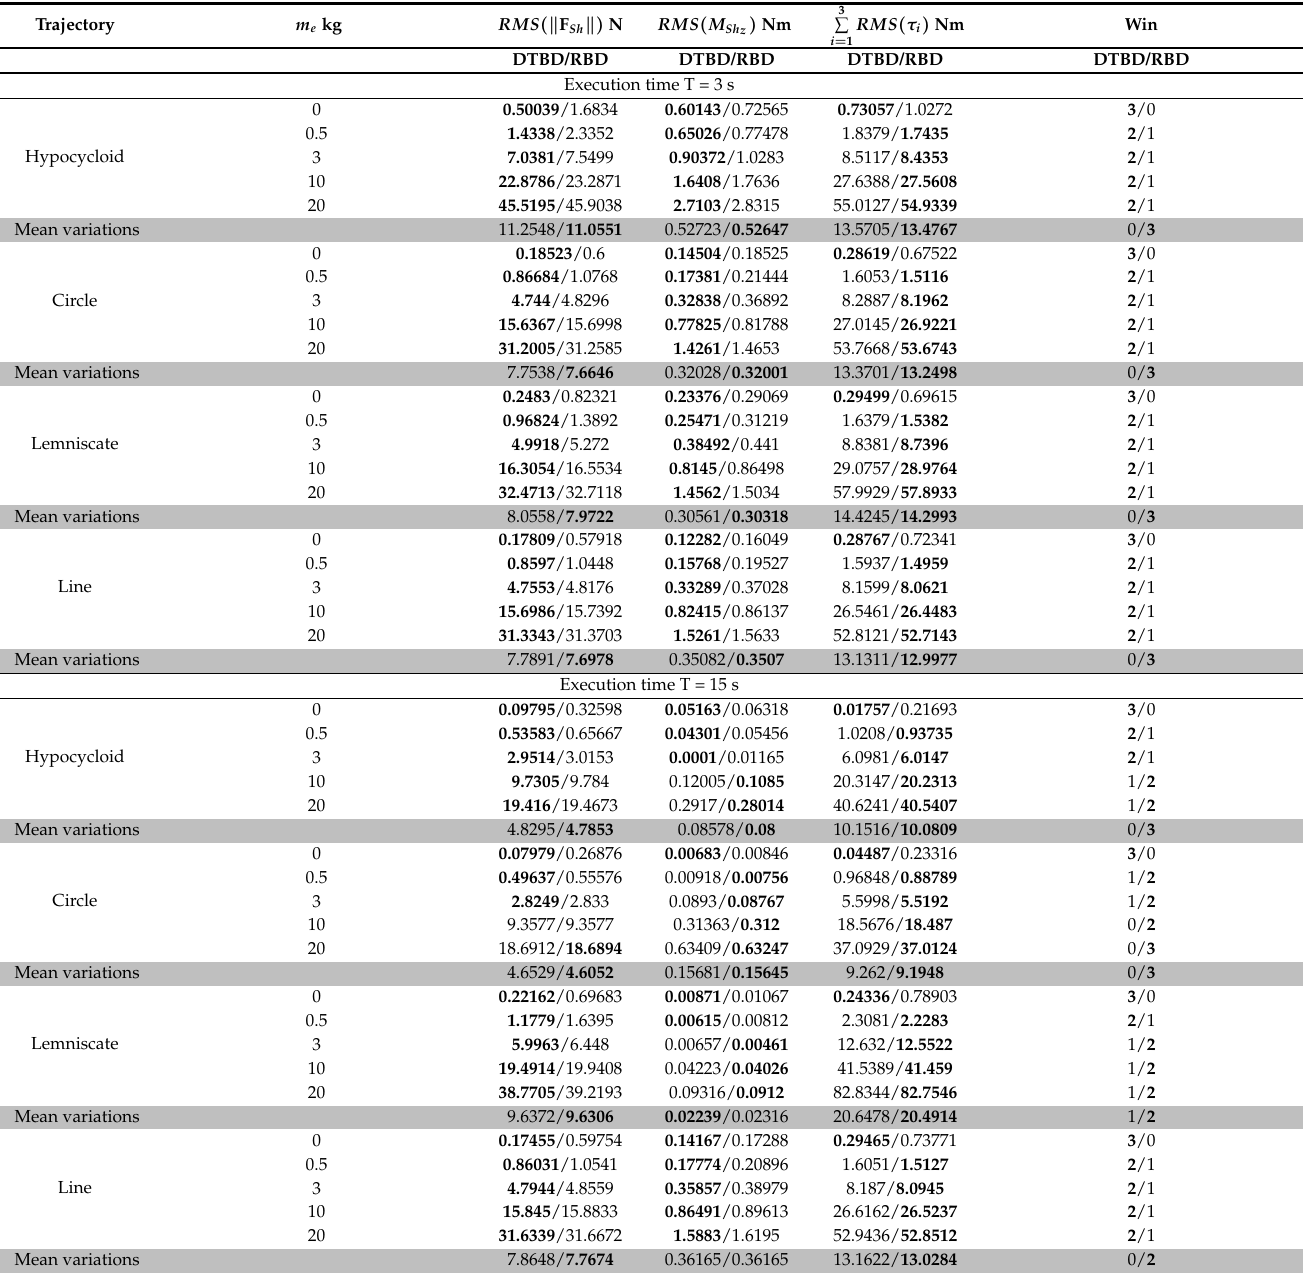
The boldface number indicates the best performance between the design approaches. The shadowed rows “Mean variations” indicate the average of the difference between the RMS value of the indicators with two different masses m e in the